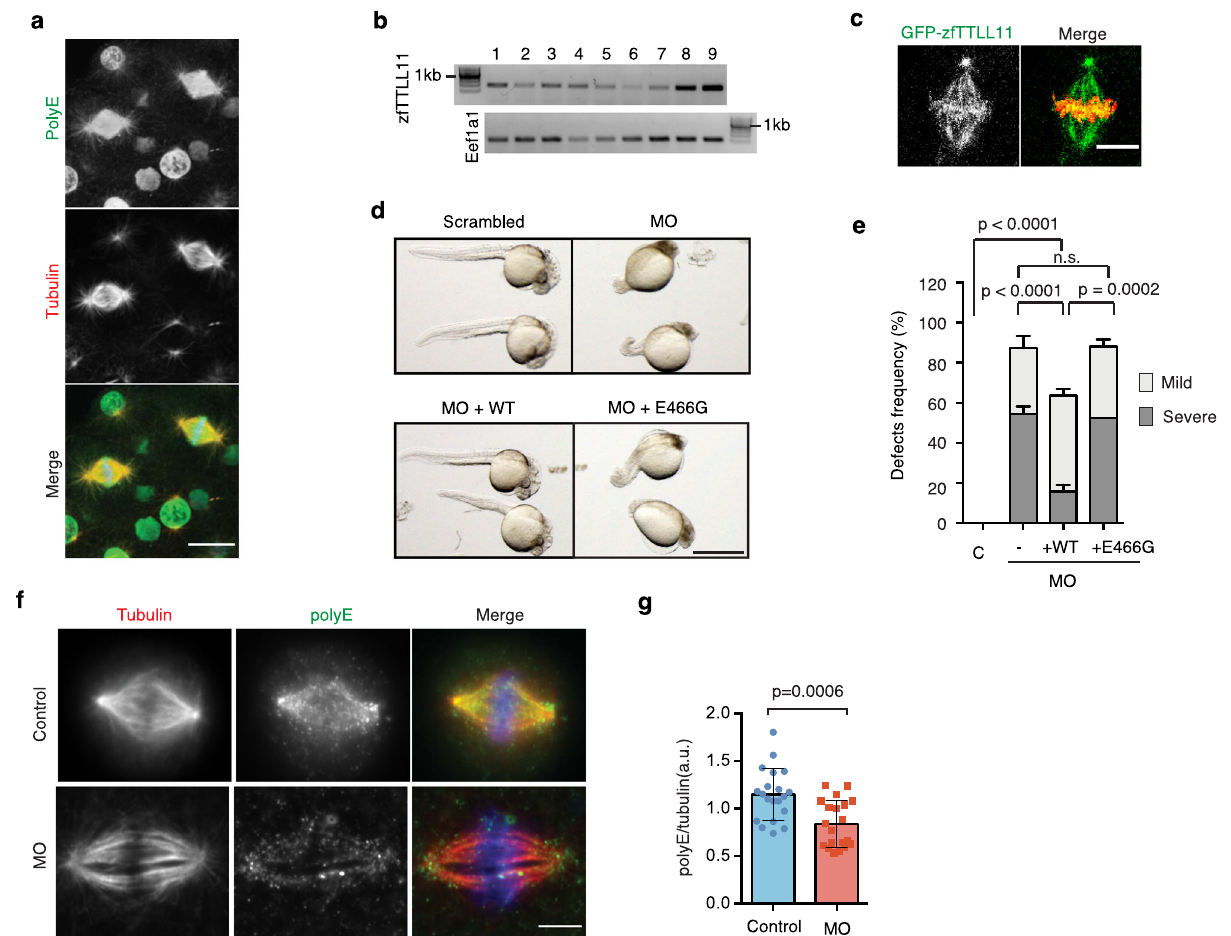
Fig. 2 | zfTTLL11 is required for early embryonic zebra fi sh development. a Immuno fl uorescenceimageofazebra fi shembryo(at4hpostfertilization[hpf]), showing PolyE (green), tubulin (red). Scale bar, 20 μ m. Representative image of N =3 independent experiments. b Semiquantitative RT-PCR showing zfTTLL11 expression in zebra fi sh embryos. Lanes 1, 4-cell stage; 2, 8-cell stage; 3, 64- cell stage;4,256-cellstage;5,sphere;6,shield;7,70%epiboly;8,90%epiboly;and9,24 hpf. Eef1a1 was ampli fi ed as a control. Representative blot of N =4 independent experiments. c Fluorescent image of a spindle in a zebra fi sh embryo expressing GFP-zfTTLL11 (green) and H2B-mCherry (red). Scale bar, 10 μ m. Representative image of N =3 independent experiments. d Zebra fi sh embryos (36 hpf) injected at the zygote stage with scrambled MO (control), zfTTLL11-Morpholinos (MO), MO and zfTTLL11 mRNA (WT) or MO and catalytically inactive zfTTLL11 (MO+E466G)